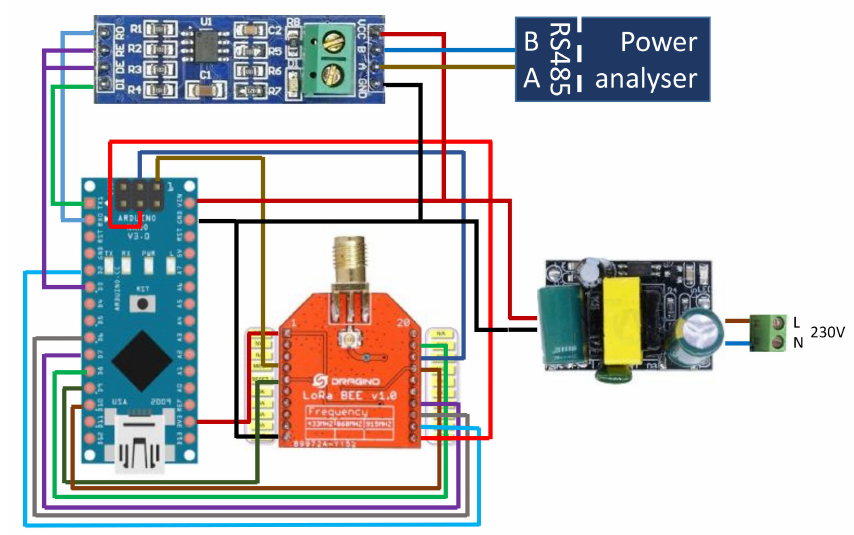
Figure 3. Wiring diagram of the PAMPD.